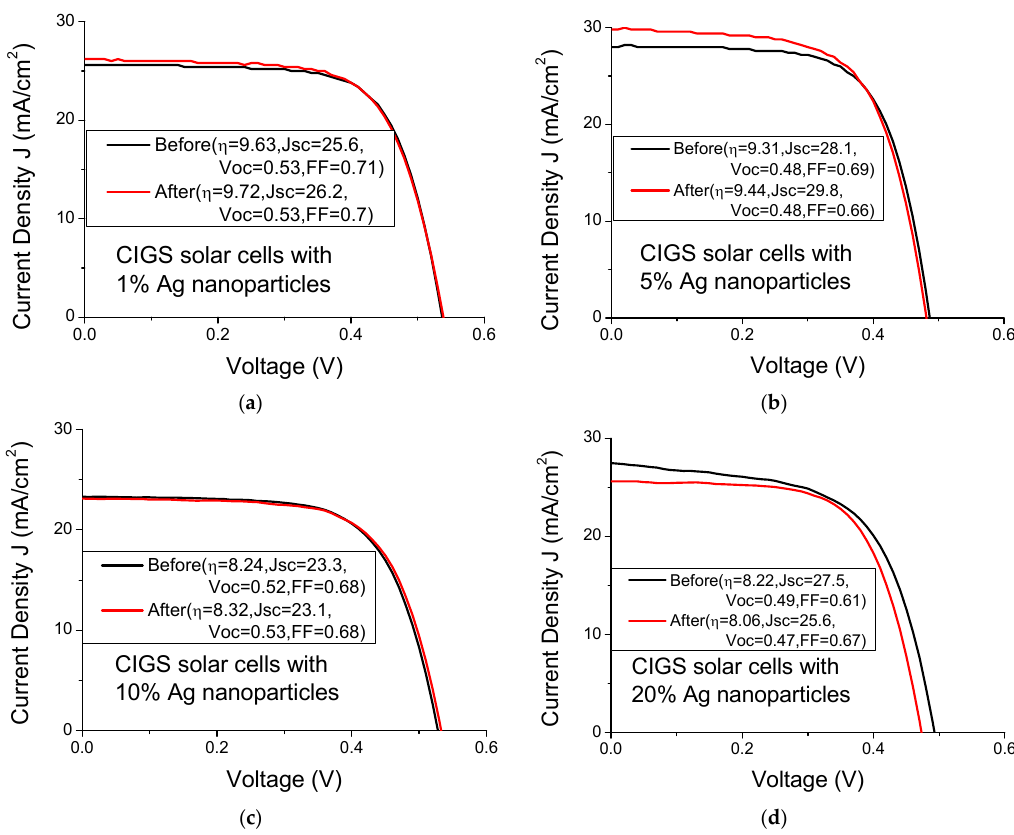
Figure 7. Current ‐ voltage curves of CIGS solar cells with various Ag nanoparticle concentrations of ( a ) 1%; ( b ) 5%; ( c ) 10% and ( d ) 20%. ( a ) 1%; ( b ) 5%; ( c ) 10% and ( d )